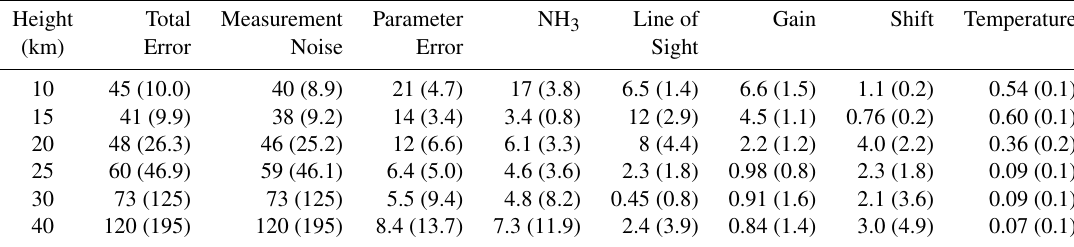
Figure 2. Top left: MIPAS OCS profile obtained from measurements at southern mid-latitudes (42.8 ◦ S, 18.7 ◦ E) on 12 July 2009 along with the measurement noise error. Top right: Rows of the respective averaging kernels (AKs). For a clearer view only every third AK is plotted. The diamonds indicate the nominal altitudes of the different AK rows. Bottom: respective vertical resolution, derived from the width of the rows of the averaging kernels. Table 1. Error budget for an OCS retrieval from spectra recorded on 12 July 2009 at 42.8 ◦ S, 18.7 ◦ E for selected altitudes. The errors are given in units of pptv, values in parentheses are relative errors in %. The total error is the sum of measurement noise and parameter error. The parameter error is the sum of uncertainties in interfering species and instrumental